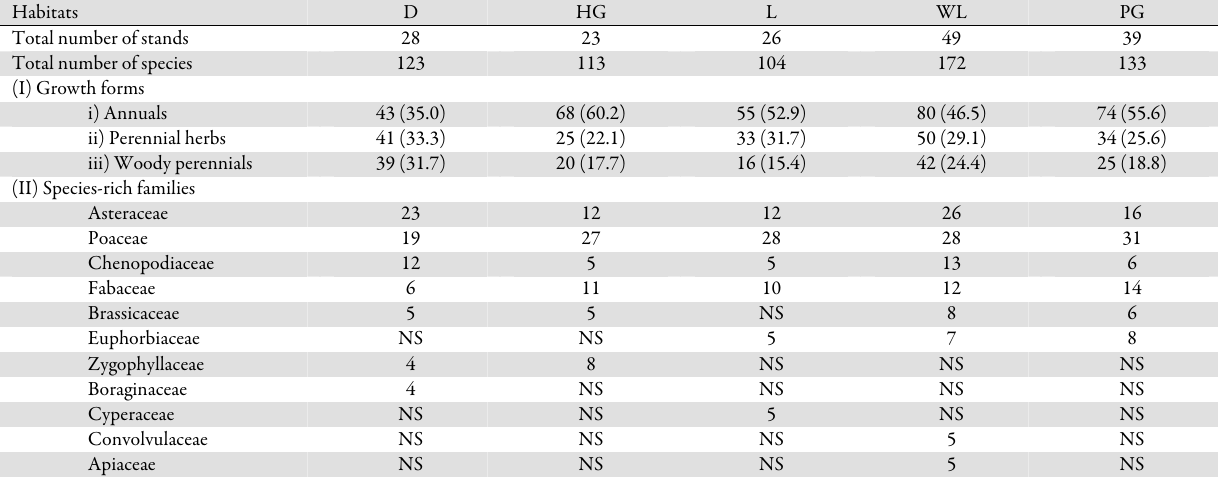
Table 1. Summary of the floristic structure in the 5 habitats: D=Desert, HG=Home gardens, L=Lawns, WL=Waste lands and PG=Public gardens. Figures between parentheses are the percentages of the total, NS=Not significant numbers